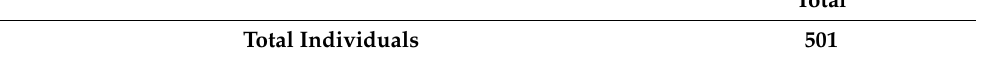
Table 8. Question 3: Why do you think fake news, that is, rumors, hoaxes, lies, is generated in the